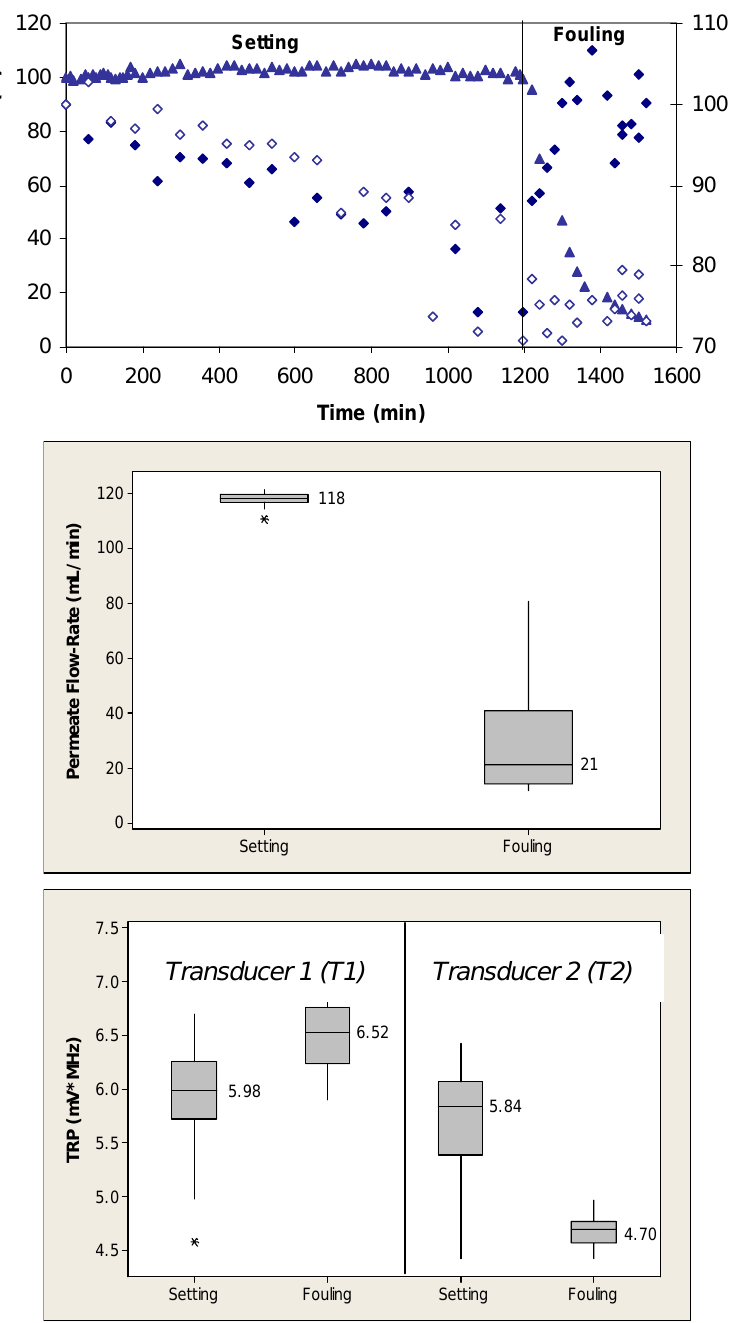
Figure 3. TOP: Permeate flow ( ▲ ) and total reflected power (TRP) from two transducers ( ♦ , ◊ ) associated with setting and fouling when PVDF membranes were challenged with 1 g/L BSA; maximum standard deviations from at least three independent observations are 6% and 22% for permeate flow and TRP, respectively. MIDDLE: Permeate flow data during the challenge represented in a box plot format where the vertical lines on the boxes indicate minimum and maximum observations; upper and lower quartiles are represented by the box boundaries and the median value is represented by the central intersecting line. BOTTOM: TRP distributions from each of two transducers mounted on the flow cells during the challenge represented in a box plot